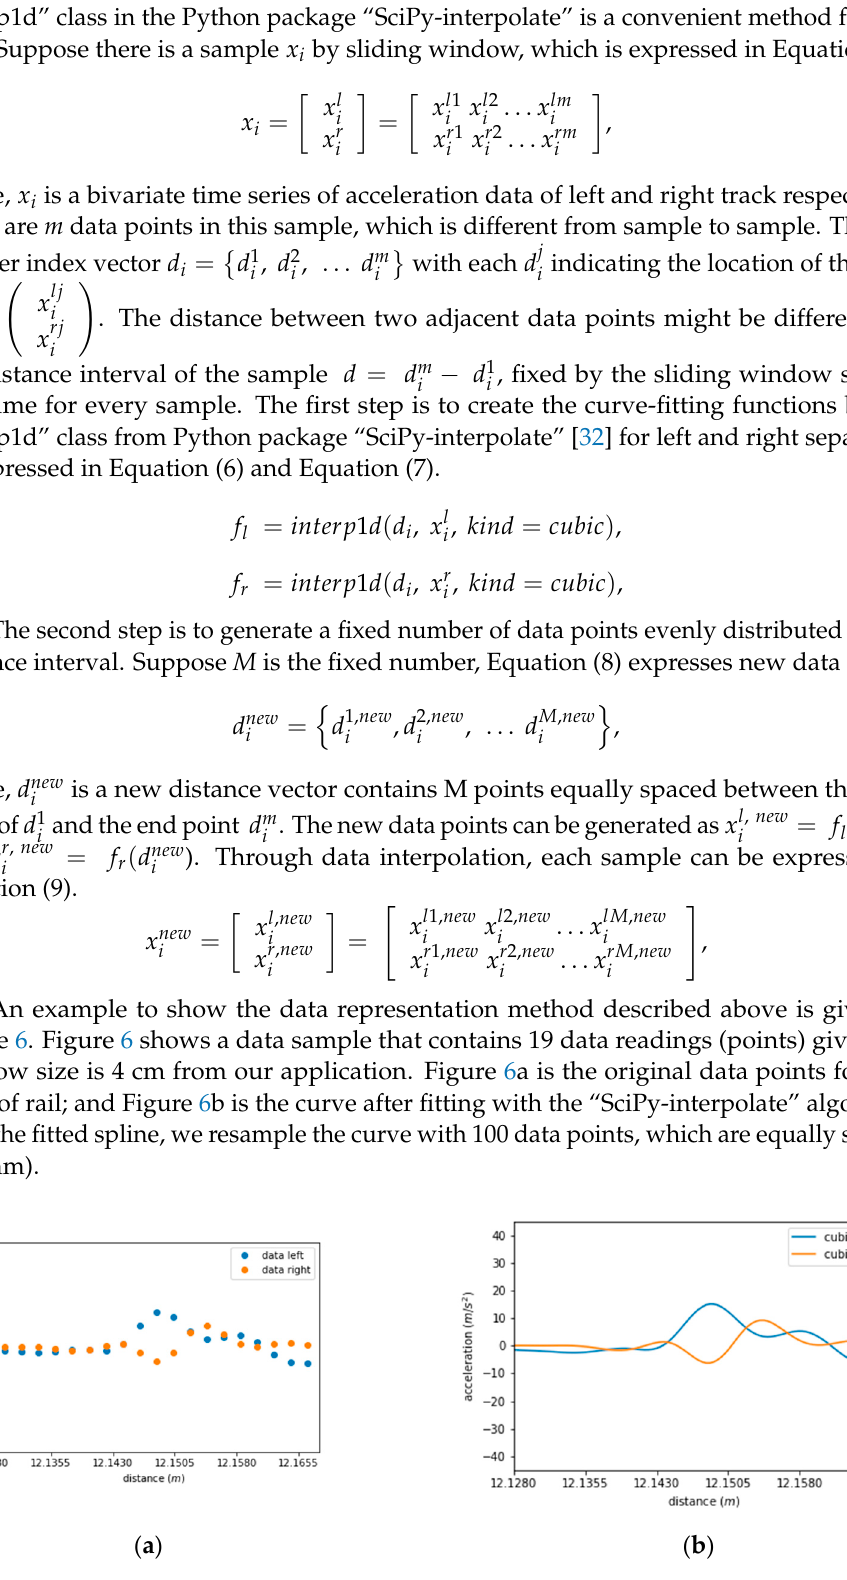
Figure 6. An example of data sample given a fixed window size (4 cm). ( a ) Original data; ( b ) cubic interpolations.